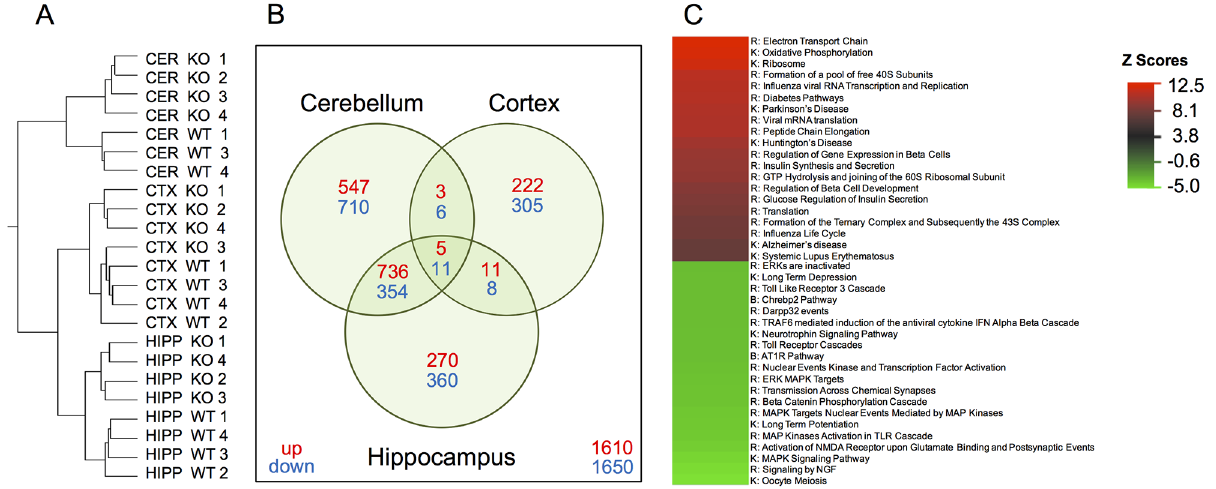
Fig 5. Bhlhe40 KO mice have unique changes in gene expression in the central nervous system. Unilateral Hippocampus (HIPP), Cortex (CTX), and Cerebellum (CER) were isolated from naïve Bhlhe40 KO and WT animals (n = 4). MRNA was extracted and run on an Illumina whole genome expression array. (A) Bhlhe40 KO and WT hippocampal gene expression had non-overlapping separation. One WT CER sample was removed as an outlier and one Bhlhe40 KO CTX clustered with the WT samples but was included in the analysis. (B) Venn Diagram of significant genes changed (p < 0.05, FDR < 0.3) in Bhlhe40 KO Cerebellum, Cortex, and Hippocampus, relative to WT). (C) Pathway analysis of a whole genome expression array on hippocampal genes identified several highly upregulated pathways in energy metabolism and downregulated pathways involved in synaptic activity in Bhlhe40 KO mice compared to WT mice. The top 20 upregulated and top 20 downregulated pathways are shown, organized by Z score; n = 4. R = Reactome; K = Kegg; B = Biocarta.